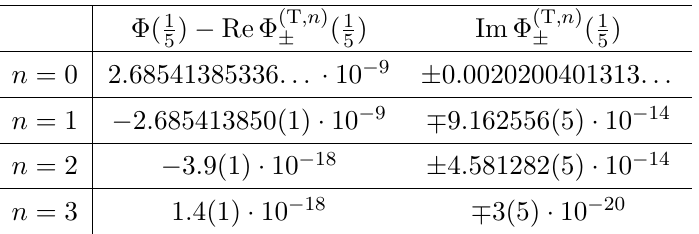
Table 2 . First orders of the truncated trans-series. In the first column the difference between the exact value and its real part and in the second column its imaginary part. The uncertainty correspond to the error associated to the Borel resummation, as explained in the main